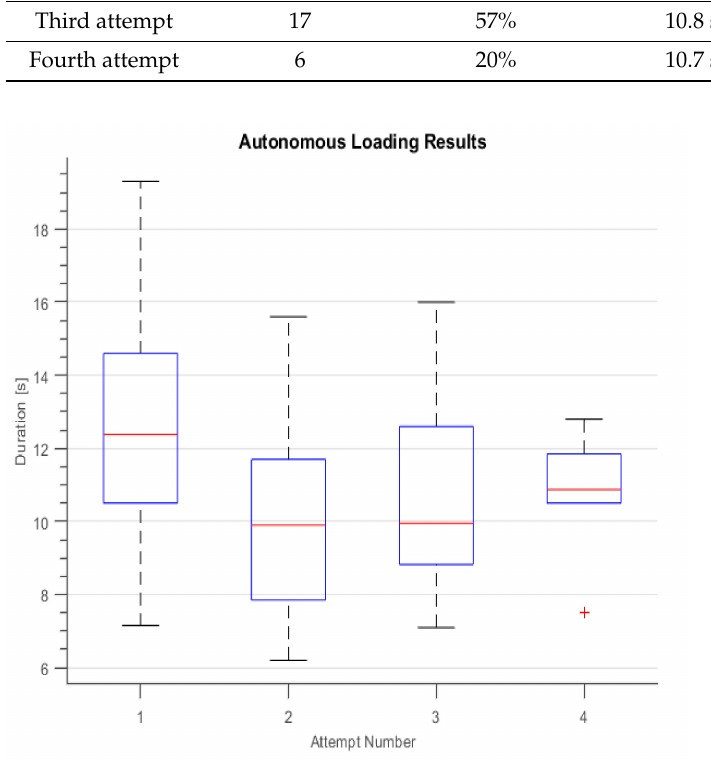
Figure 24. Excavation step duration per loading attempt. Red “+” signs represent outliers.